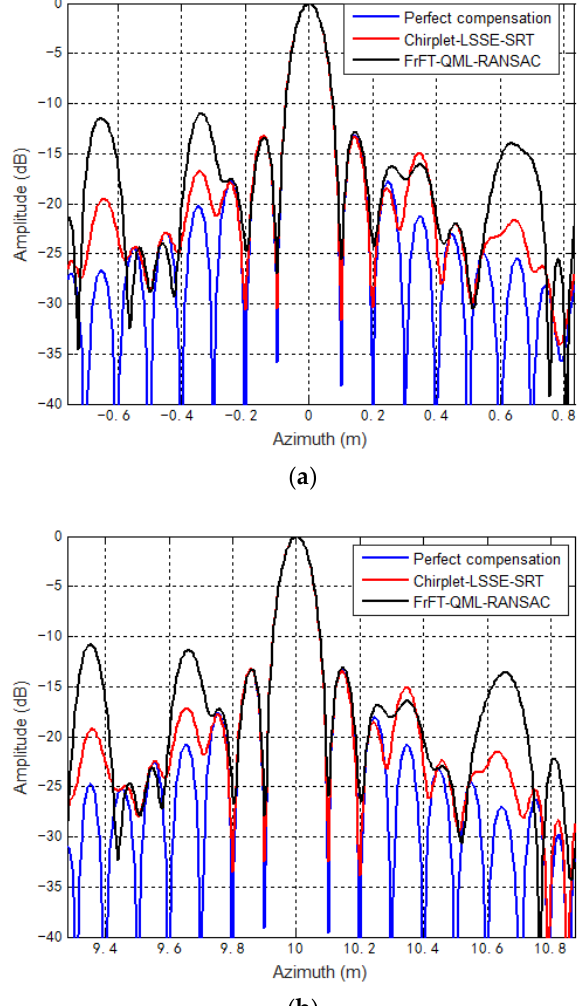
Figure 10. Azimuth response of point targets. ( a ) Point target P4 of Figure 9c; ( b ) point target P9 of Figure